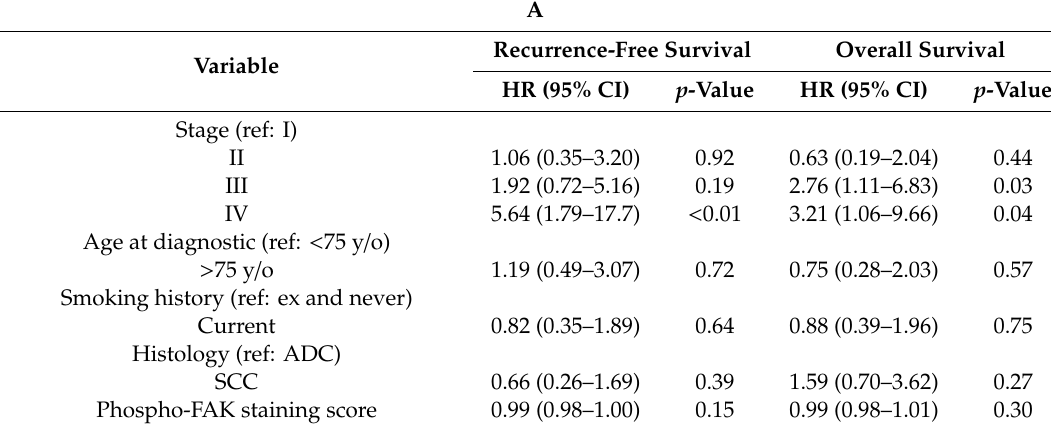
Table 3. Multivariate Cox proportional regression analysis for the association with recurrence-free survival and overall survival of ( A ) phospho-FAK staining score in NSCLC ( n = 95) and ( B ) the ratio between phospho-FAK and FAK staining scores in SCLC patients ( n =